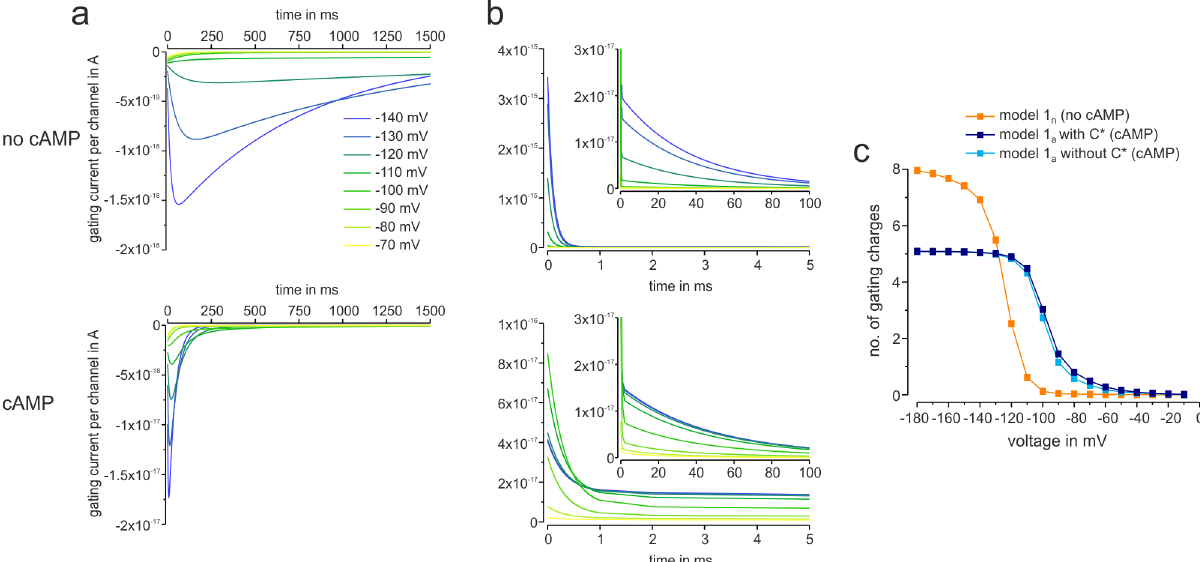
Fig 5. Effect of cAMP on computed gating currents per channel and moved gating charges. The gating currents per channel were computed with model 1 n (no cAMP) or 1 a (10 μ M cAMP). The holding potential was set to 0 mV. ( a ) ON-gating currents at the voltages between -140 and -70 mV. The main effect of cAMP is to significantly accelerate both the rising and the decay phase of the gating current, resulting in an increase of the peak amplitude. ( b ) OFF-gating currents at -40 mV following voltage pulses indicated in (a) containing a fast and a slow component. Both components are decreased by cAMP. ( c ) Effect of cAMP on the total gating charge computed by integrating the gating currents for a voltage pulse of 1.5 s duration in the absence and presence of cAMP. The holding potential was set to 0 mV. The effect of the voltage-dependent transition C 1 ! C 1 (cid:3) is only minor.